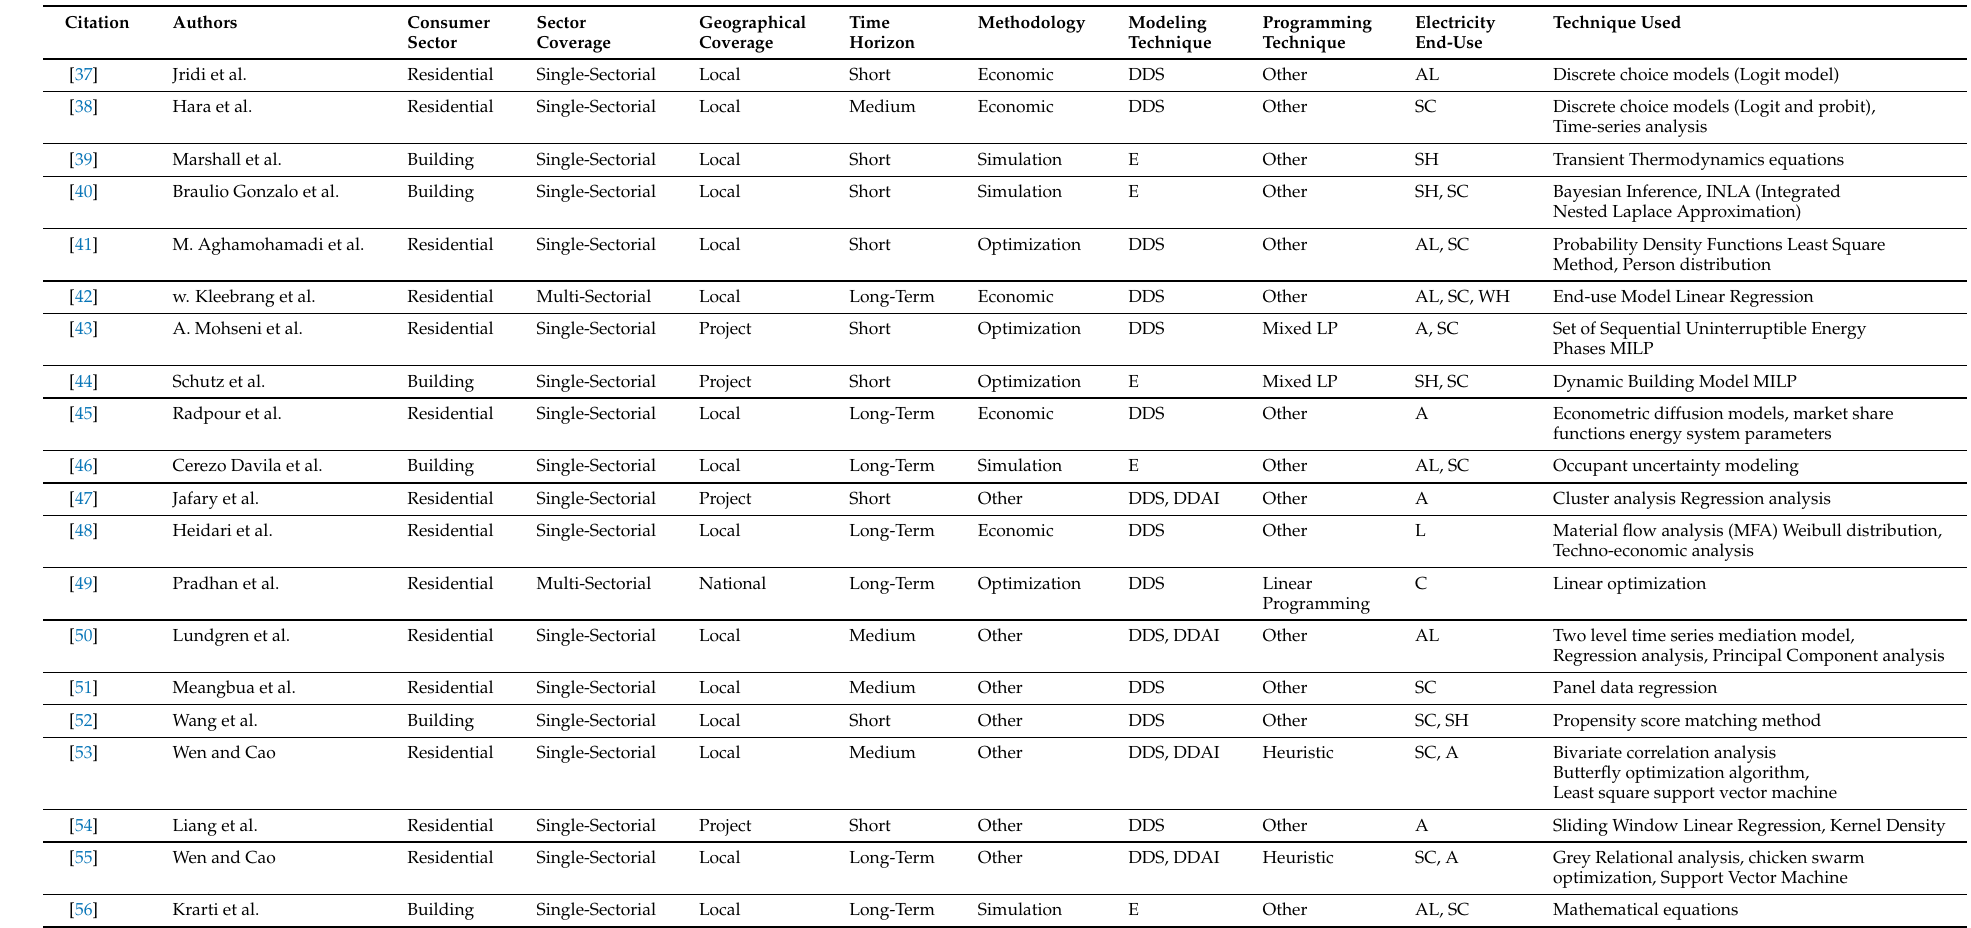
Table 7. Article Classification by Bottom-up model